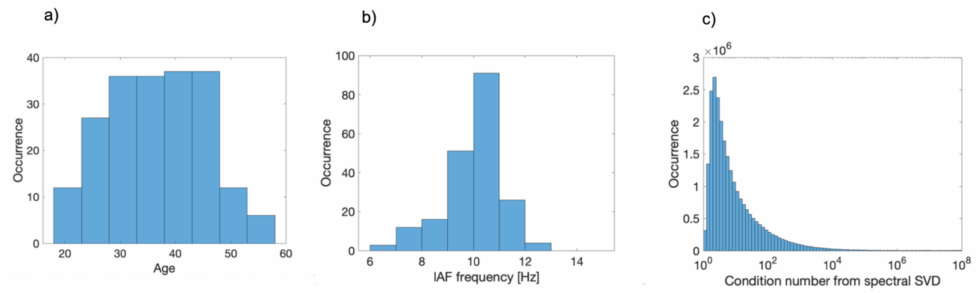
Figure 1. ( a ) Distribution of sample age. ( b ) Distribution of detected IAF on the whole sample. ( c ) Distribution of all condition numbers from SVD, aiming to define optimal dipole direction for spectral